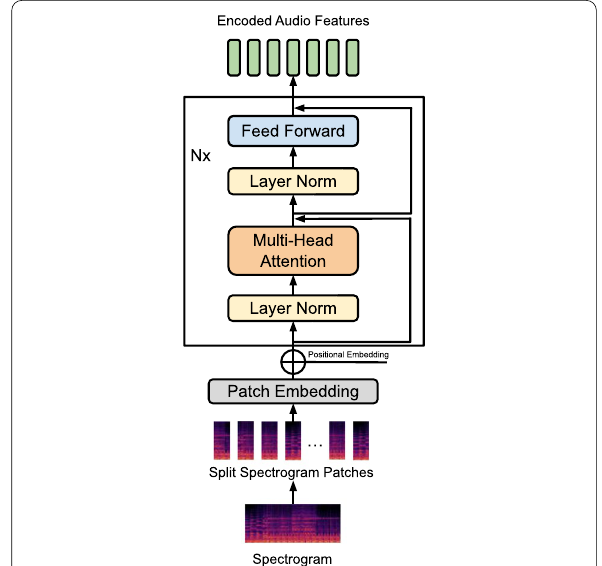
Fig. 4 Diagram of the Transformer-based audio encoder. The input spectrogram is first split into small patches. These patches are then projected into 1-D embeddings through a linear layer, where a positional embedding is further added to each patch embedding to capture position information. The resulting embeddings are then fed into the Transformer blocks to obtain the encoded audio